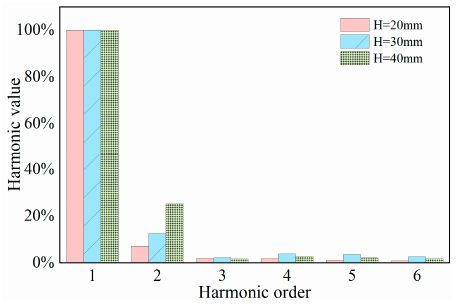
Figure 12. Harmonic distribution of EMF under different strokes. Figure 11. EMF curve of PMLG under different strokes.